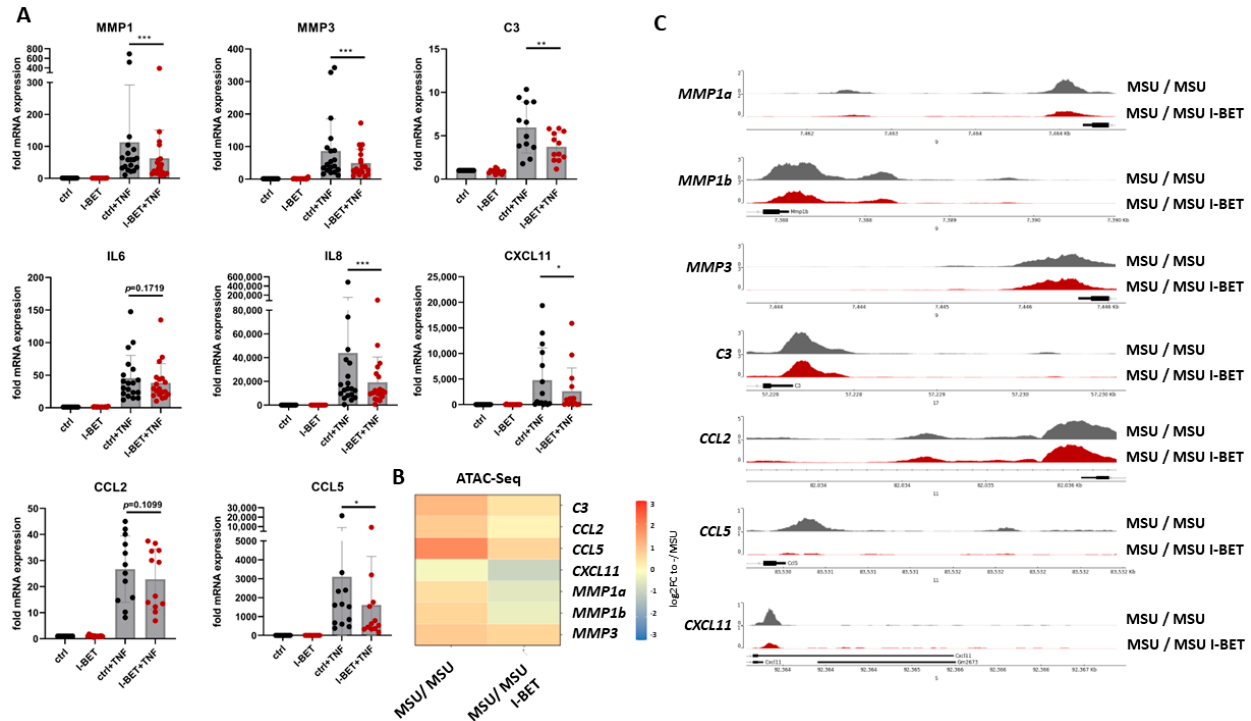
Figure 4. Long-lasting effects of I-BET151 on TNF-induced gene expression and MSU-induced open chromatin states. ( A ) FLSs were treated with a single dose of I-BET151, and treated with TNF after 5 days for 24 h ( n = 19). The expression of MMP1, MMP3, C3, Il6, IL8, CXCL11, CCL2, and CCL5 was measured by real-time PCR. ( B ) Log2 fold change (FC) in expression of selected genes generated from ATAC-Seq counts on annotated promoters, calculated as the ratio to the mean normalized counts from FLSs isolated from mouse paws after a single injection of MSU crystals (pooled data from 3 replicates from 2 mice/cell pools). ( C ) Genome tracks displaying normalized pro fi les for ATAC-Seq signals 2 kb upstream of transcription start sites of indicated genes. Each lane shows pooled data from 3 replicates of FLS cultures from 2 mice/pool. * p < 0.05, ** p < 0.01, *** p < 0.001.